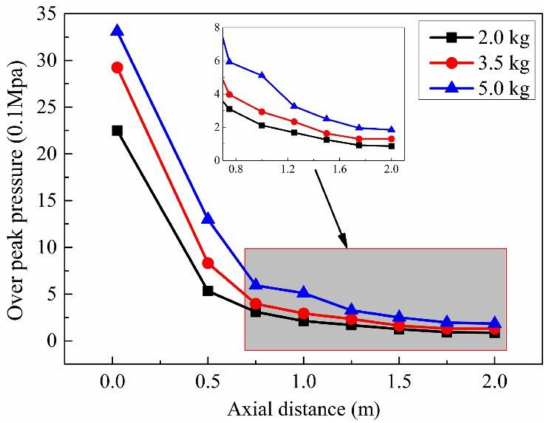
Figure 22. The peak pressure of each gauge point in the case of different explosive